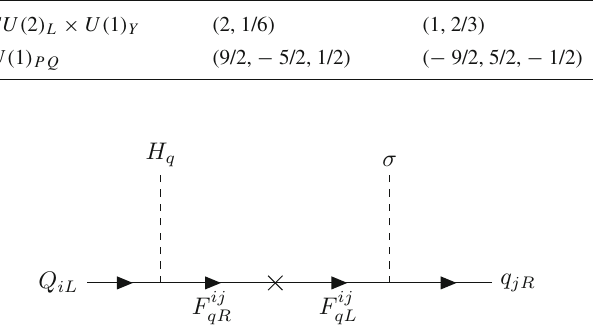
Table 1 Field content and transformation properties of the PQ-symmetry under the DFSZ type-I seesaw model, where i = 1 , 2 , 3 represent families of three quarks Fields/symmetry